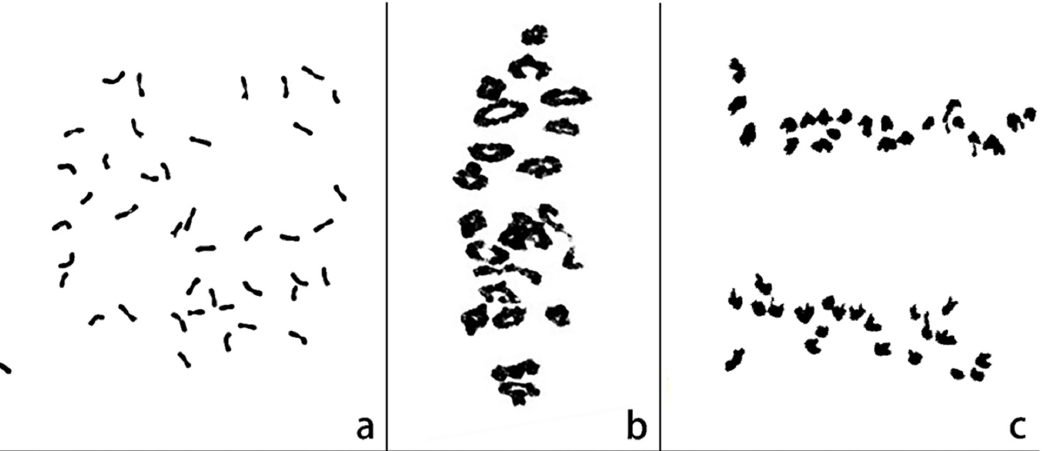
Figure 1. Cytogenetic analysis of 17DM48. ( a ) root tip cell at mitotic metaphase, 2 n = 42. ( b ) chromosomal configuration of pollen mother cell at meiotic metaphase, 2 n = 21 II. ( c ) chromosomal configuration of pollen mother cell at anaphase I, 2 n = 21 + 21.